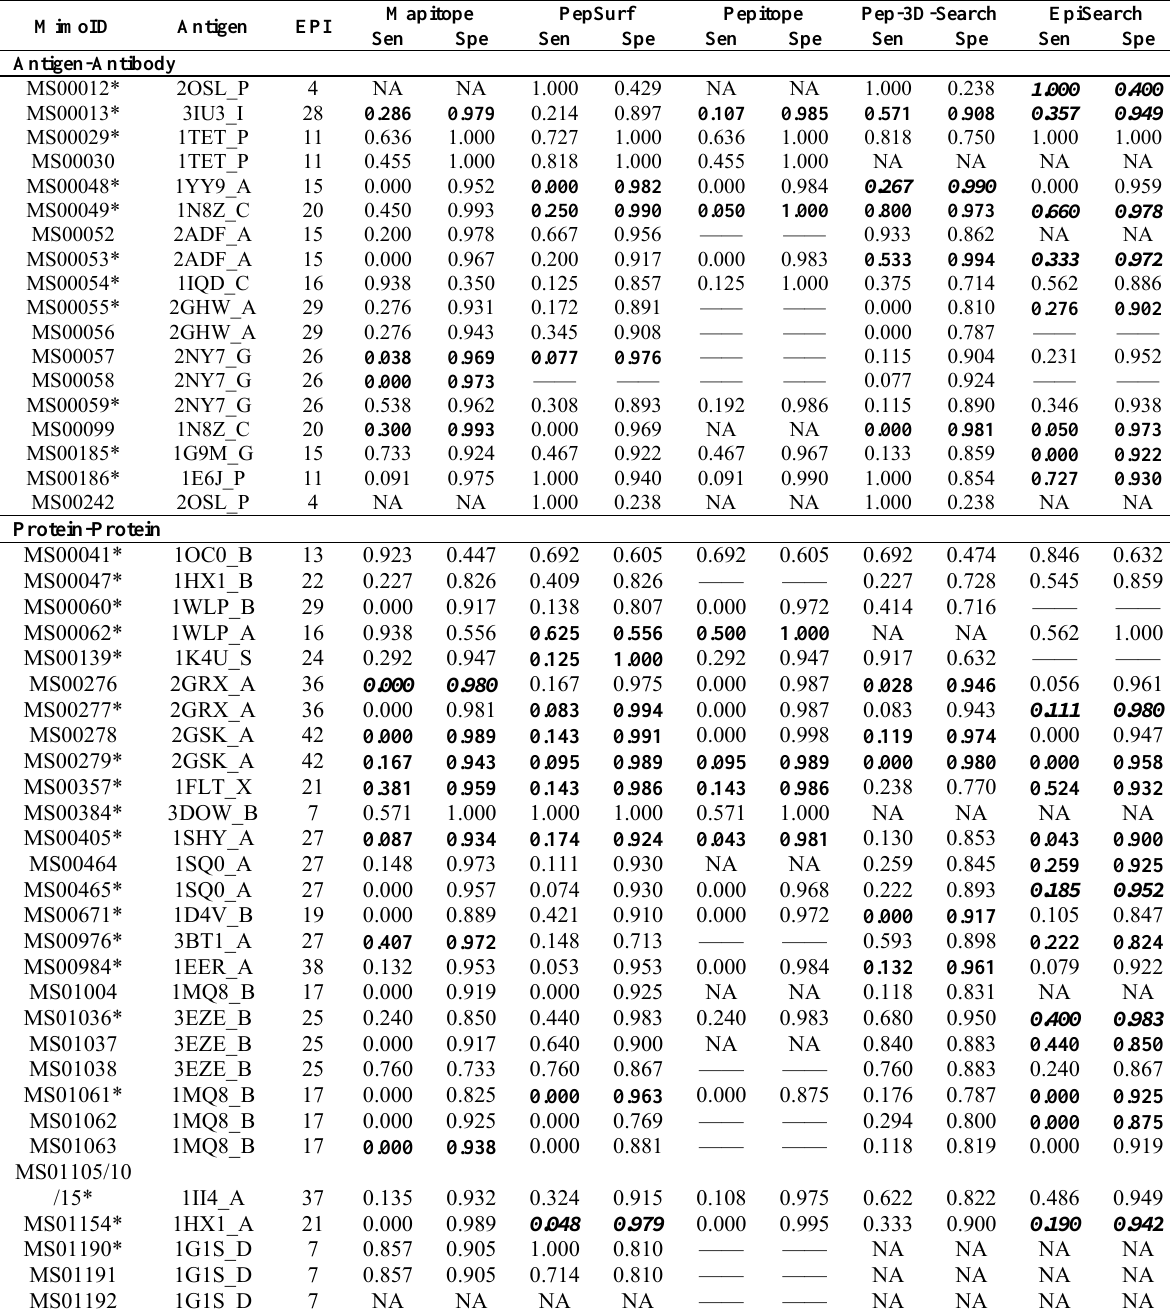
Table 3. Sensitivity and specificity of each method on the benchmark dataset. The data which belong to the representative dataset were marked with *. (1) ‘NA’ means that the results for epitope prediction were not obtained; (2) ‘—’ means that the data has restriction of the sequence length or the sequence number; (3) The best resulting cluster that was found in the second-ranked cluster is shown in bold; (4) The best resulting cluster that was found in the third-ranked cluster is shown in italic; (5) “EPI” means the residue number of the